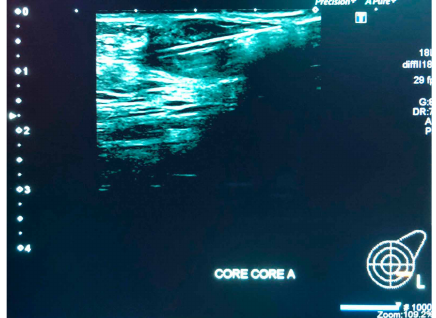
Figure 7: Ultrasound-guided core biopsy image of the first lesion (14-gauge needle).